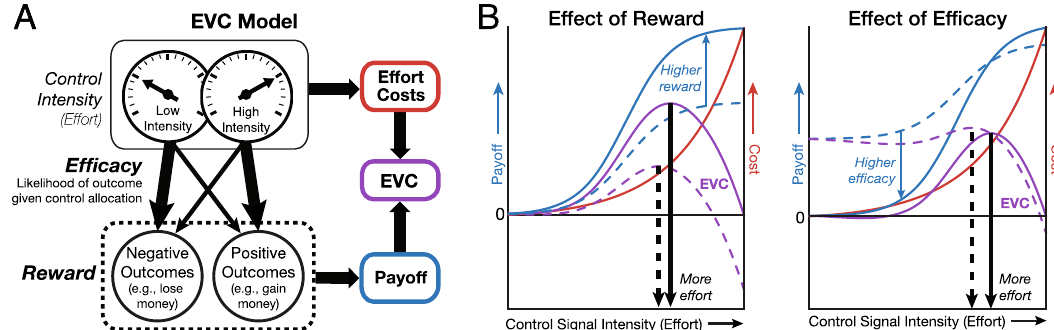
Fig. 1 The expected value of control (EVC) model predicts that control should increase with expected reward and ef fi cacy. A EVC model. Control intensity is chosen to optimize the trade-off between effort costs and payoff, maximizing the expected value of the control. The payoff of a given control signal is determined by the expected reward and ef fi cacy for a given control intensity. B The EVC model proposes that higher intensities of control ( x axis) are associated with greater effort costs (red) but that these effort costs can be outweighed by the expected payoff for a given control intensity (blue). These payoffs typically increase as a function of task performance, and task performance typically improves as a function of control intensity. The EVC of each control intensity (purple) is calculated as the difference between its payoff and its cost. The optimal level of control to invest is the one that maximizes EVC (vertical black arrows). Left: When the expected reward for performing the task well is higher (from dashed to the solid line), higher control intensities achieve even higher payoffs. Right: When performance matters less for acquiring a given reward (low ef fi cacy (dashed line)) — here, simulated by having reward be unrelated to performance on most trials (instead, occurring at a fi xed high rate; see Fig. 2) — the relative payoff for high vs. low control intensities